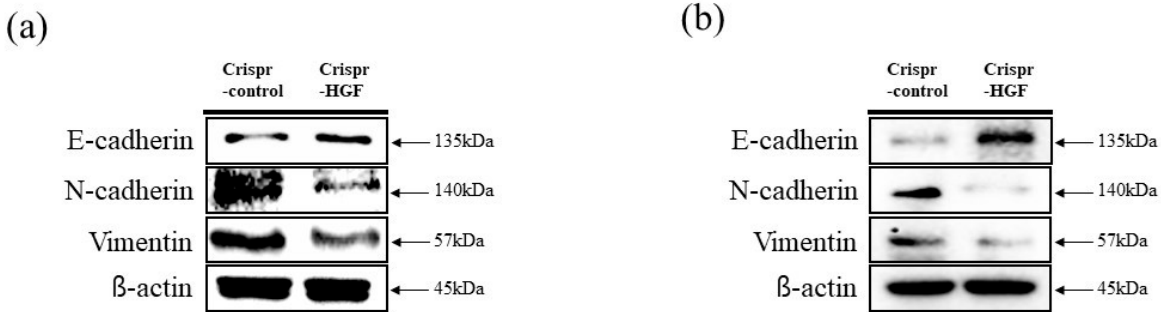
Figure 7. The expression levels of proteins related to cell migration through Western blot assay. The cells were transfected with Crispr-Control and Crispr-HGF for 72 h. The expression levels of E-cadherin were increased in Crispr-HGF-transfected ( a ) Huh7 and ( b ) Hep3B cells compared to control group. However, the expression levels of N-cadherin and Vimentin were decreased in Crispr-HGF-transfected cells compared to control group in both cells.